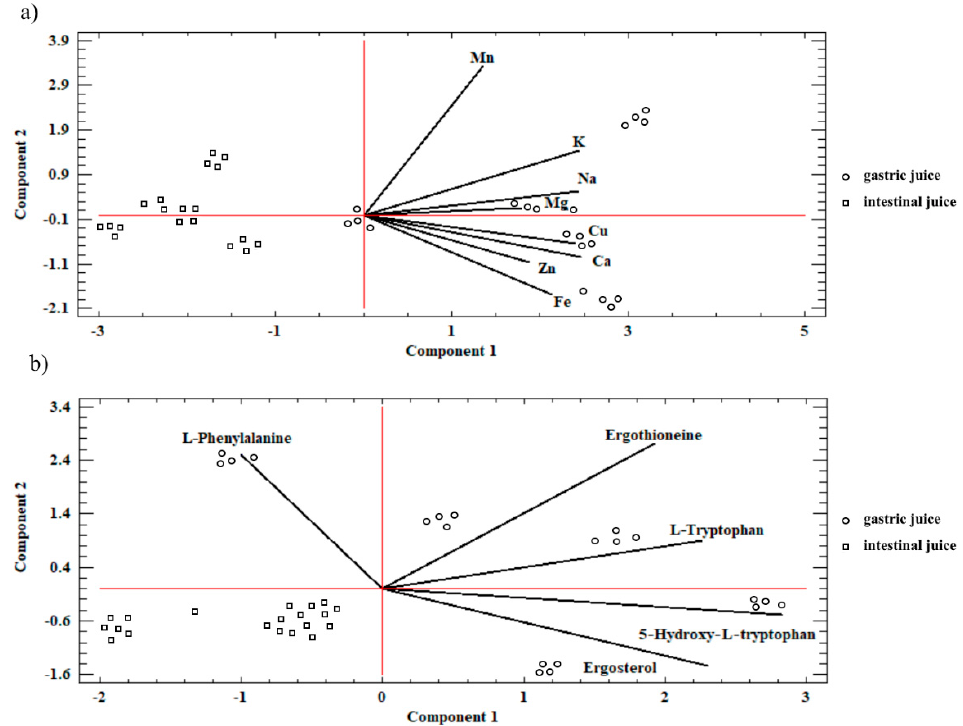
Figure 4. Plot of the similarity of C. militaris samples in relation to the place of their extraction in artificial digestive juices: ( a ) bioelements; ( b ) organic compounds.